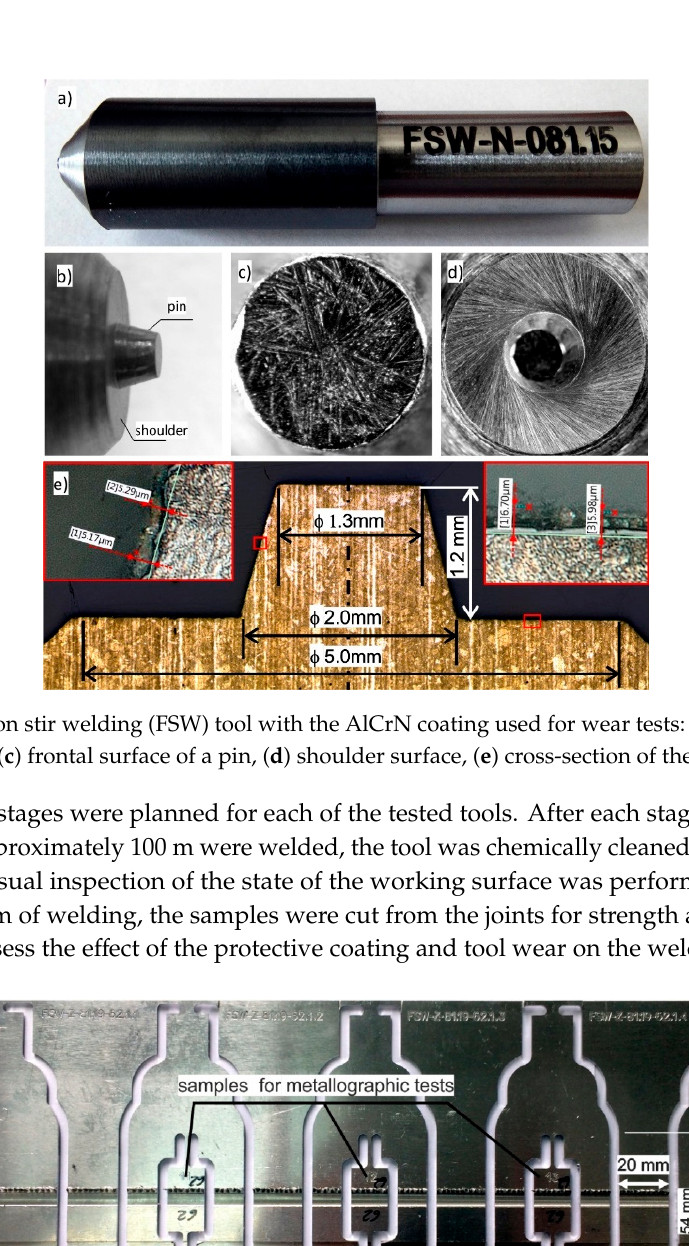
Figure 2. Joint welded during wear tests of FSW tools.